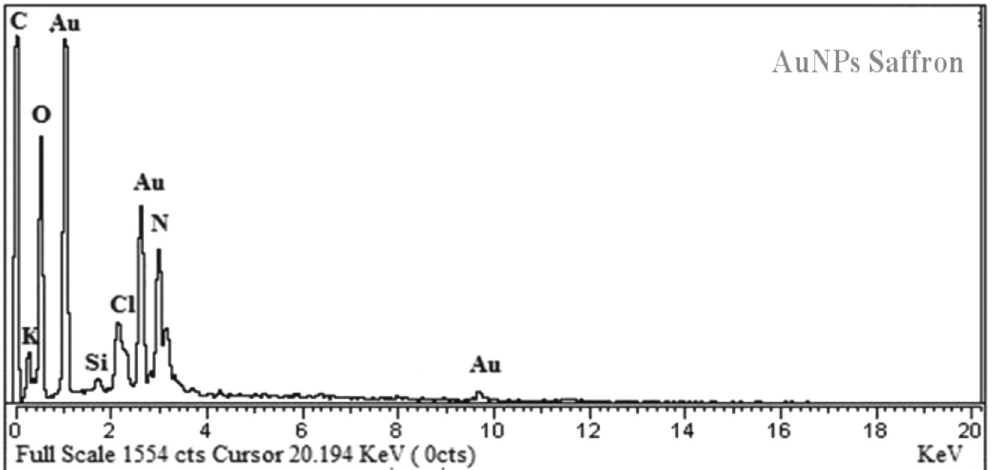
Figure 14: EDX spectra of sa ff ron loaded gold nanoparticles ( SS - AuNPs )